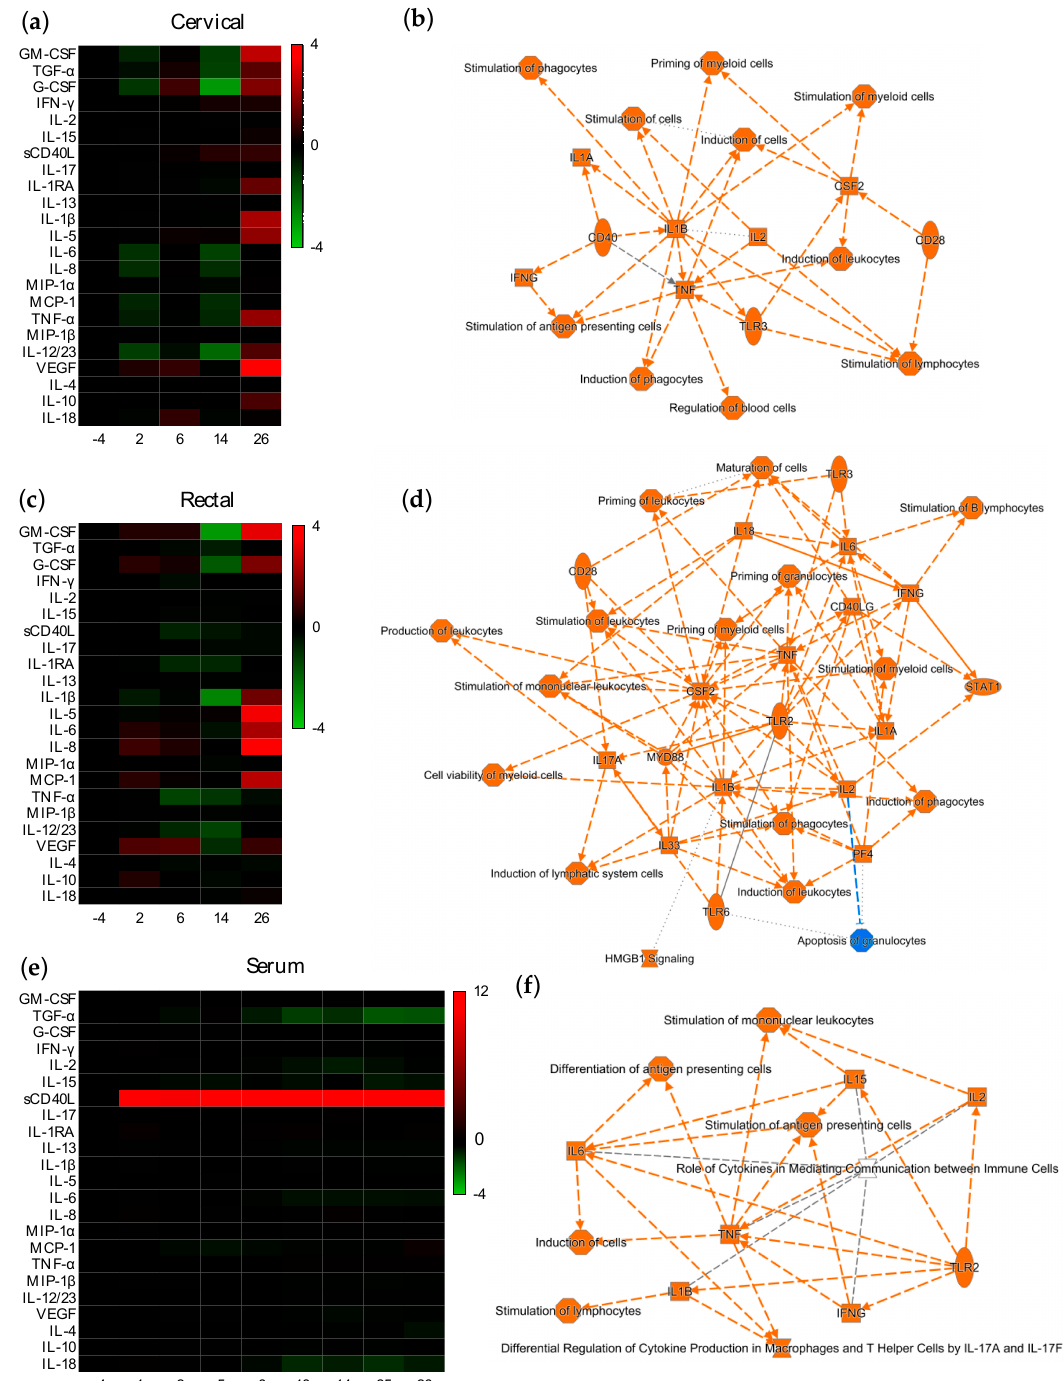
Figure 3. Effect of vaccination on the mucosal and systemic cytokine profile. Heatmap representing cytokines in ( a ) cervical or ( c ) rectal tissues, and in ( e ) serum that are upregulated (red) or downregu- lated (green) 1 or 2 weeks after each vaccination in comparison to the baseline profiles at week -4. Differences are shown in Log2 from two independent experiments performed in quadruplicate. Inter- action maps of the functional pathways associated with the cytokine/chemokine nodes modulated at week 26 in ( b ) cervical explants, ( d ) rectal tissue or ( f ) serum. Colors: blue: downregulated; or- ange: upregulated. Symbols: oval: transmembrane receptor; square: cytokine/chemokine; diamond: enzyme; inverted triangle: kinase; hourglass: canonical pathway; octagon: function. Lines: solid: direct interaction; dashed: indirect interaction; doted: inferred correlation from Ingenuity Pathway Analysis machine-based